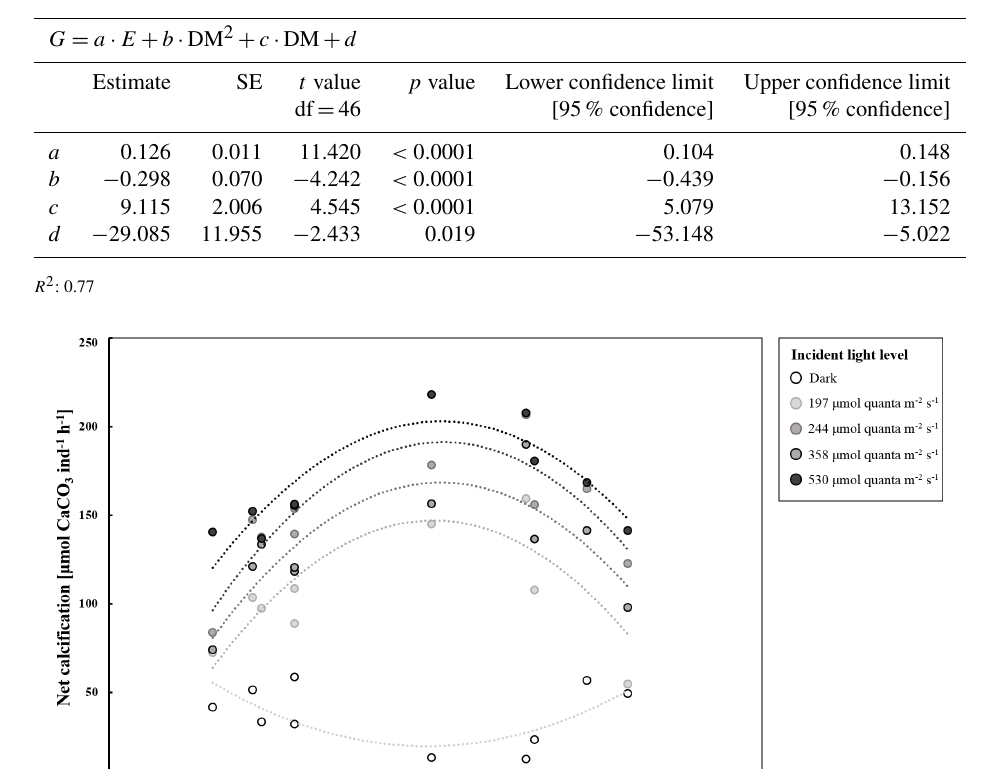
highest abundances of T. maxima in shallow water ( < 3